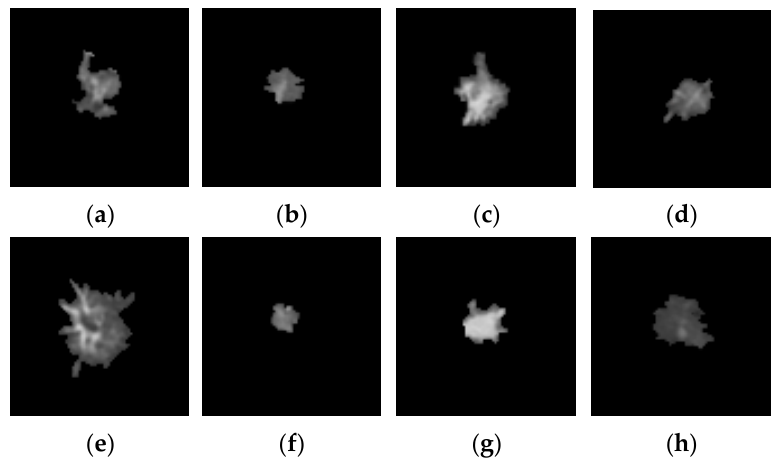
Figure 1. Examples of IA and non ‐ IA nodules images. ( a – d ) Segmented IA nodules, ( e – h ) segmented non ‐ IA nodules. ( a , e ) Larger volume; ( b , f ) smaller volume; ( c , g ) more solid components; ( d , h ) less solid components.